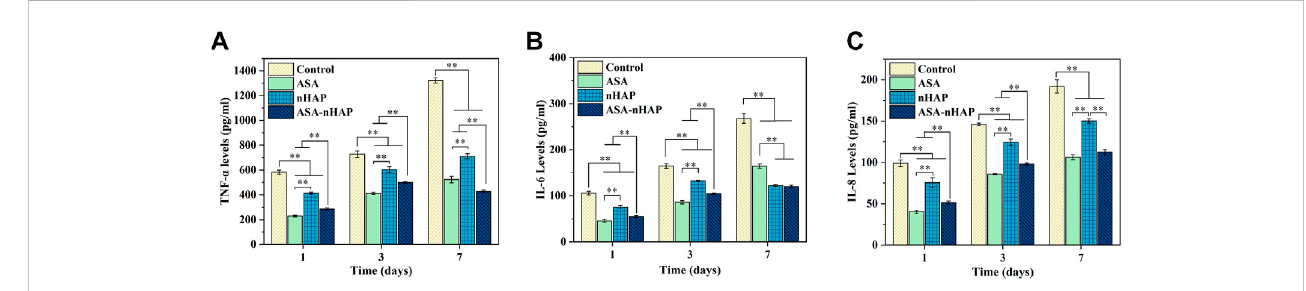
FIGURE 6 Expression ofthein fl ammatorymediatorsofMC3T3-E1 cells inthein fl ammatory environmentafter 1,3, and7 d (A) TNF- α . (B) IL-6. (C) IL-8. (** p <